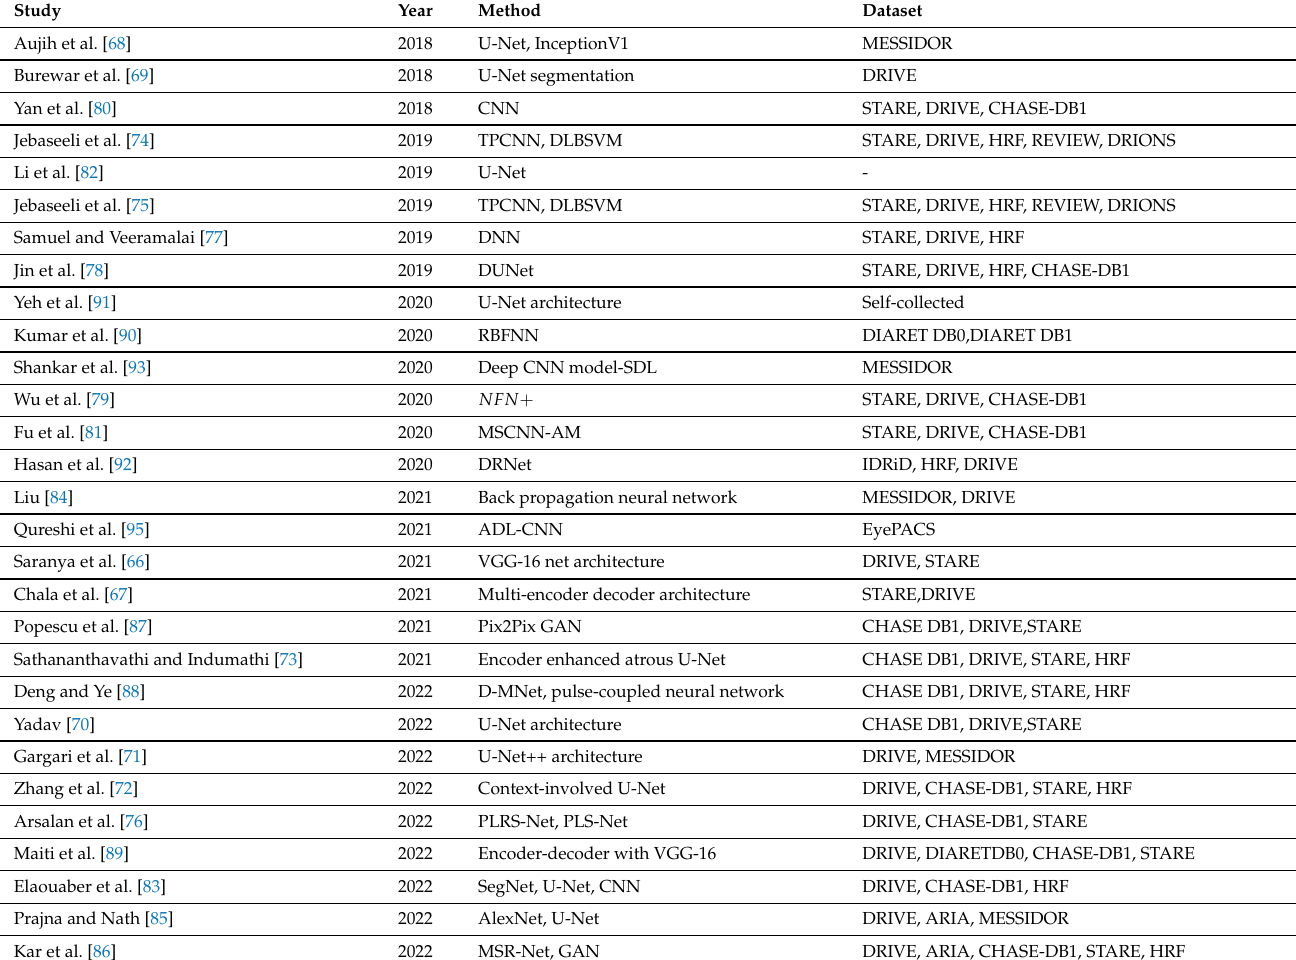
Table 2. Deep-learning based approaches for diabetic retinopathy